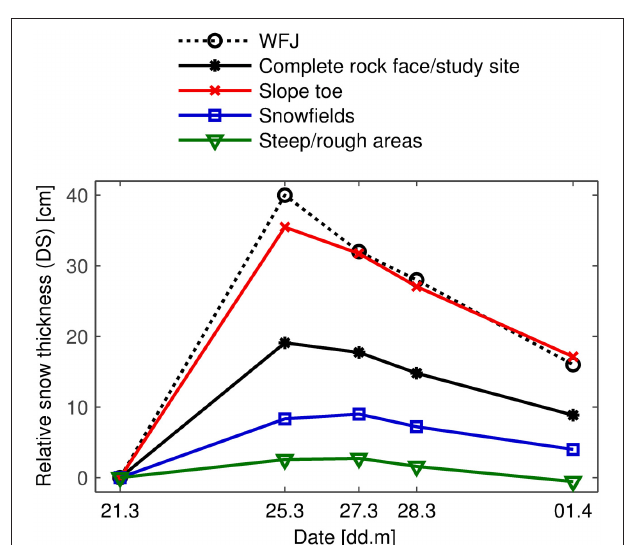
FIGURE 8 | Evolution of the snow thickness relative to 21 March. WFJ: reference station at Weissfluhjoch. Note the increase in the “snowfields” between 25 and 27 March as well as the stronger decrease at WFJ compared to the “slope toe” in the same period.